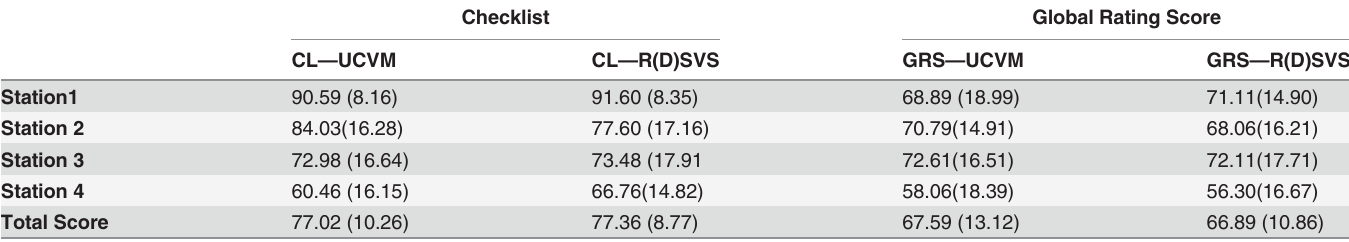
Table 1. Mean percent scores (and standard deviations) from UCVM and R(D)SVS raters for OSCE Checklist and Global rating